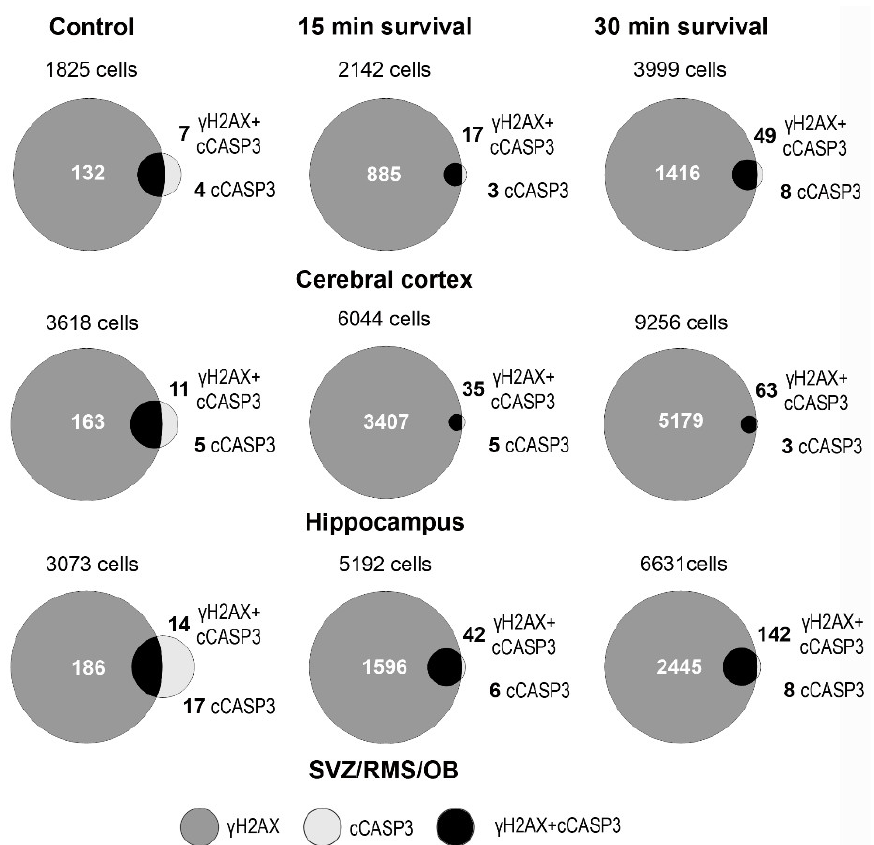
Figure 10. Visual representation of γ H2AX + cCASP3 colocalization with quantitative Venn diagrams. The number at the top of each diagram is the total number of cells labeled with DAPI. Note that in control animals the cCASP3 immunoreactive cells represent a higher fraction of those labeled with γ H2AX and that there is a relatively large population of cCASP3 single-labeled cells in these animals. Irradiation reduces the percentage of cCASP3 immunoreactive cells versus those labeled with γ H2AX and leads to a drastic reduction of the cells singularly labeled for cCASP3 that almost disappear in the hippocampus and SVR/RMS/OB (see also Table 1).